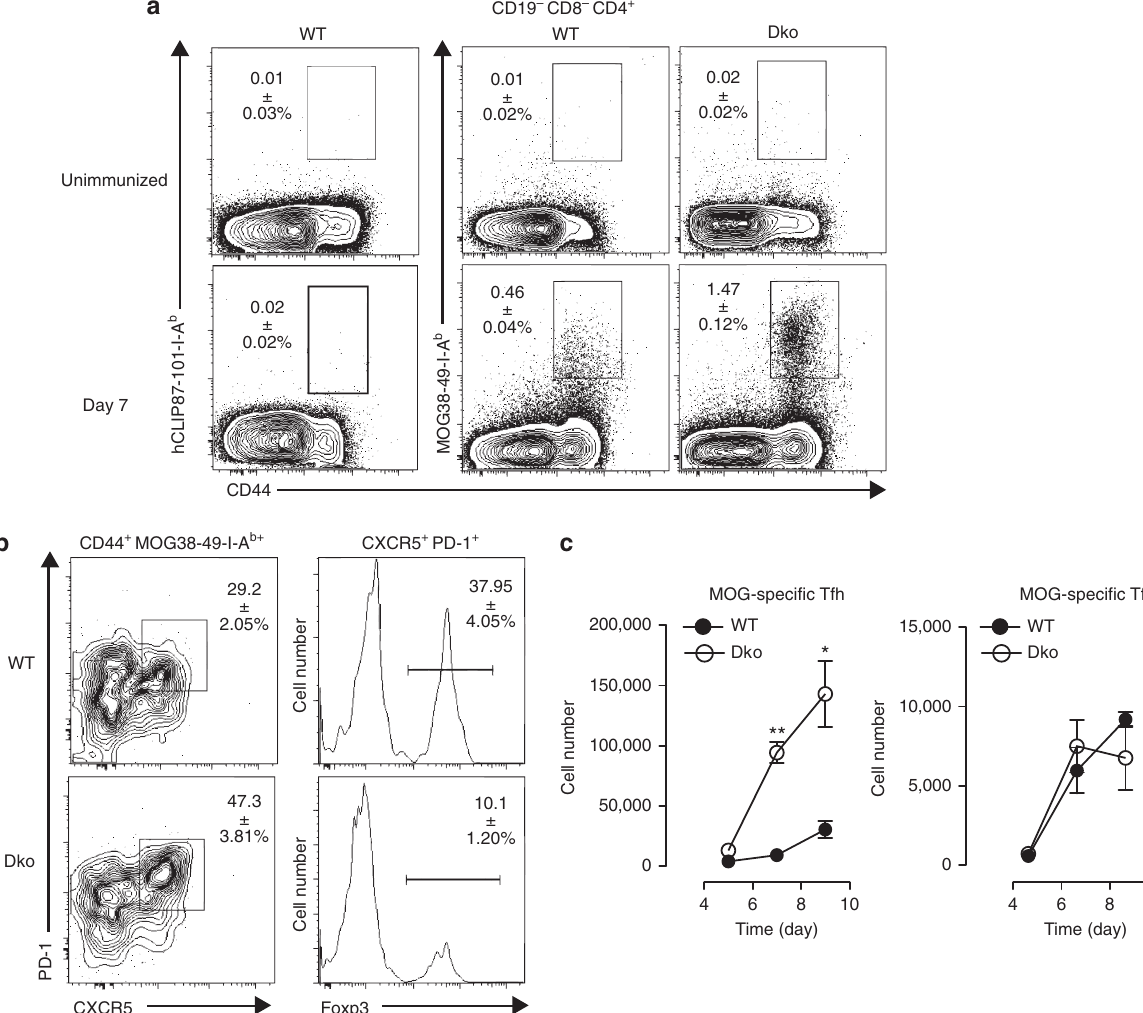
Figure 1 | Tfr and Tfh cells are specific for the immunizing Ag. ( a ) hCLIP87-101-I-A b , MOG38-49-I-A b and Foxp3 staining of CD19 (cid:2) CD8 a (cid:2) CD4 þ dLN (inguinal and periaortic) cells (see Supplementary Fig. 1) from unimmunized WT and Dko mice (top panels) and from WT and Dko mice 7 days after immunization with MOG in CFA (bottom panels). ( b ) WTand Dko mice were immunized with MOG35-55 emulsified in CFA. dLNs were harvested 7 days after immunization for the detection of MOG-specific activated CD4 þ Tcells (CD44 þ MOG38-49-I-A b þ ) and, among them, the follicular cells (CXCR5 þ PD-1 þ ). Within the latter, we identified Tfr cells (Foxp3 þ ) in both WTand Dko mice. ( c ) The mean absolute numbers of total MOG-specific Tfh cells and MOG-specific Tfr cells over time in dLN after immunization of WT (solid circle) or Dko mice (open circle); error bars represent s.e.m. In a , b the numbers in the dot plots represent the mean ± s.e.m. Data shown are from a single experiment with five mice per time point and are representative of three independent experiments. Data were analysed using the non-parametric Mann–Whitney test. * P o 0.05; ** P o